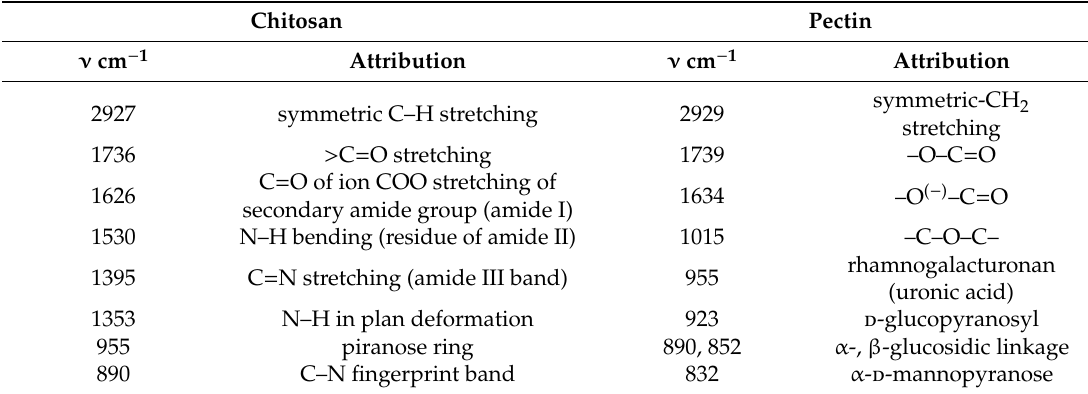
Figure 2. FTIR spectra of Ch:P and Ch:P containing natural halloysite nanotubes (HNT) without and with natural antioxidants. Table 2. Assignment of main IR absorption bands of chitosan and pectin [24,25].